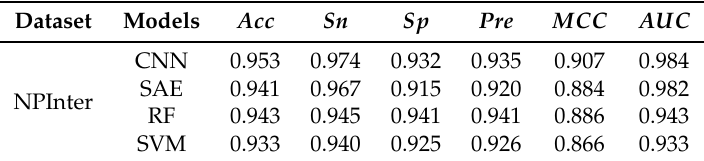
Table 2. Performance comparison between convolution neural network (CNN), stacked auto-encoder (SAE), random forest (RF), and support vector machine (SVM) on dataset NPInter by five-fold cross validation.